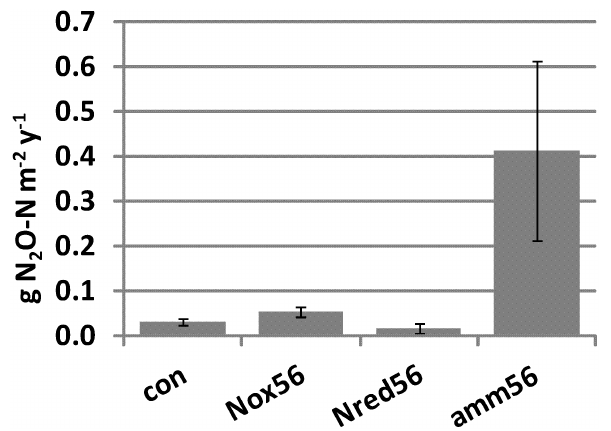
Fig. 6. Mean N 2 O-N flux ( + / − sterr) from the control (no added N) and N treated (oxidised (Nox), reduced (Nred) and ammonia (amm)) plots ( ∼ 56kgNha − 1 yr − 1 ) at Whim bog in 2009 and 2010.